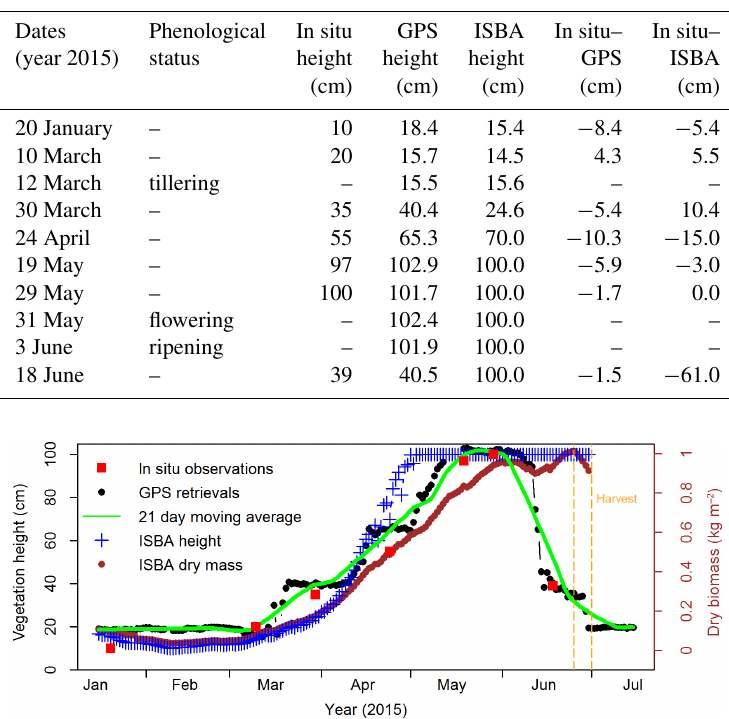
Figure 7. Wheat canopy height from 16 January to 15 July 2015 derived from GPS SNR data (black dots), from in situ observations (red squares), and from ISBA simulations (blue crosses). The green line represents the moving average of the GPS retrievals, computed using a centered gliding window of 21 days. Wheat above-ground dry biomass simulated by the ISBA model is indicated by dark red